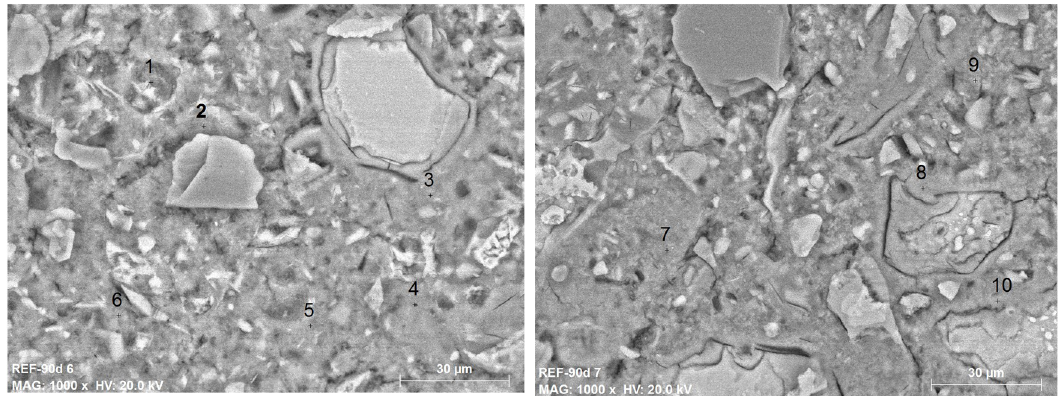
Figure 5. BSEM images ×1000 of the REF concrete. The numbers show the exact position of the EDAX shown in Table 7. Table 7. EDAX microanalysis specified in the BSEM images of Figure 5 (main oxides, wt.%); REF concrete. EDAX